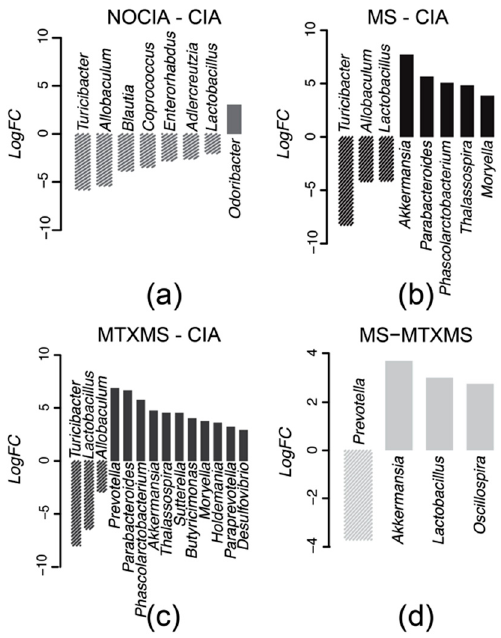
Figure 3. Gastrointestinal microbial differential analysis. Therapy-wise genera differential analyses between ( a ) NOCIA and CIA; ( b ) MS and CIA; ( c ) MTXMS and CIA and ( d ) MS and MTXMS. Data are represented by log fold change (log-FC) with limma (FC ≥ 2, p ≤ 0.05).